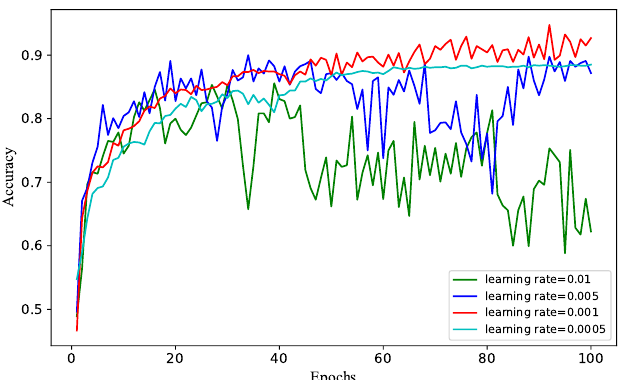
Figure 21. The recognition accuracy of Bi-LSTM sub-network with different learning